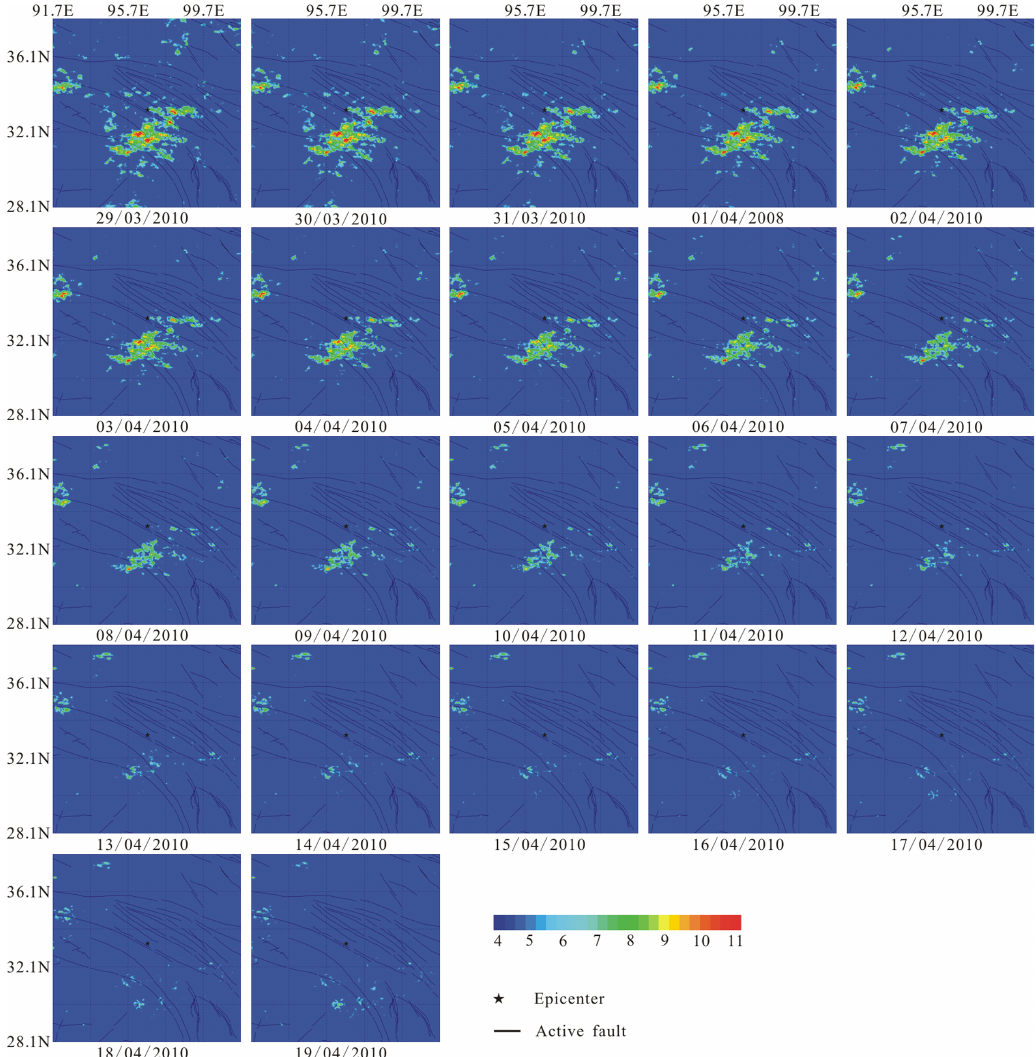
Fig. 3. Spatial-time evolution of the RWPS based on brightness temperature data from FY-2E. For each pixel, value of RWPS means multiples of wavelet power over its average of the two years. Analysed areas are located at eastern Qinghai-Tibetan Plateau. Weather conditions are very complex at different areas, with many short-time fluctuations. Though the power of short-time fluctuations is mainly distributed at high frequency bonds (we focus on RWPS variations whose periods are greater than 8days), there are still some noise pixels scattered in RWPS images of low frequency bonds. This situation is improved in the analysis of eastern areas of China. The main anomalies are located at the southern areas of epicentre. Anomalous areas and amplitude dwindled and earthquake occurred